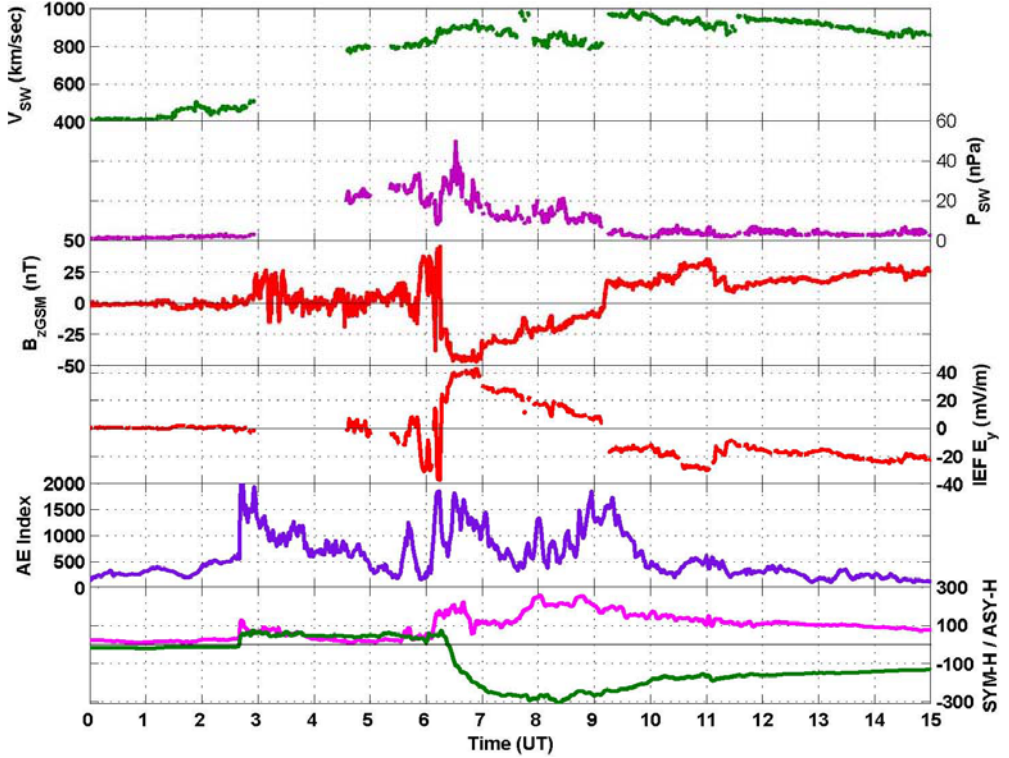
Fig. 1. The solar wind speed, ram pressure, IMF B z , zonal interplanetary electric field (IEF E y ), AE index, SYM-H and ASY-H indices variations on 15 May 2005. A large eastward electric field after 06:15UT is clearly seen. Three episodes of large AE index are also